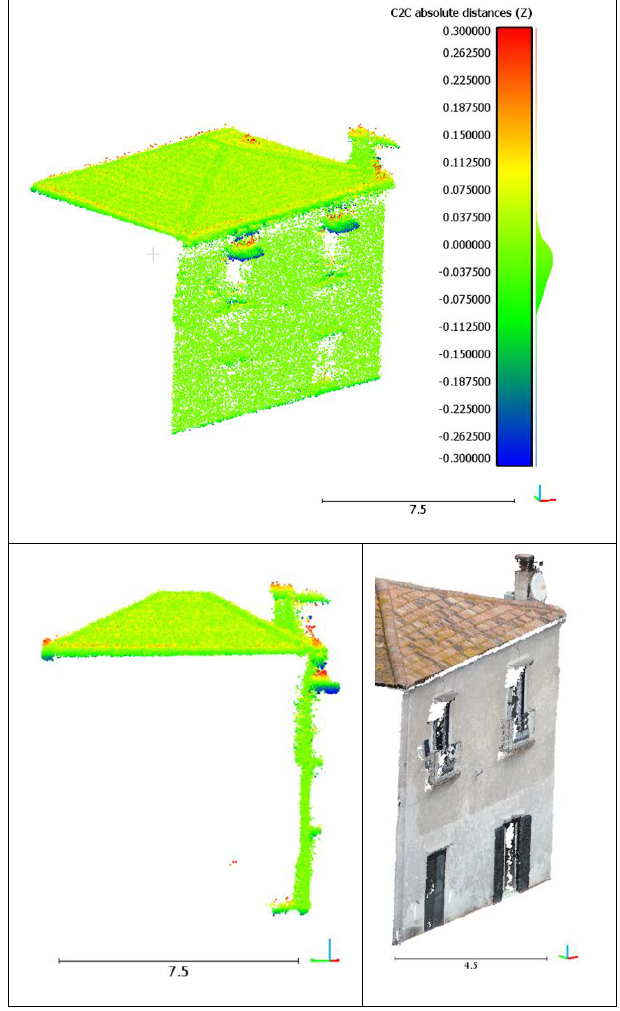
Figure 2 . The largest distance values along z calculated are at the window canopies. Below you can see the different acquisition in the case of sensor L1 (left) and P1